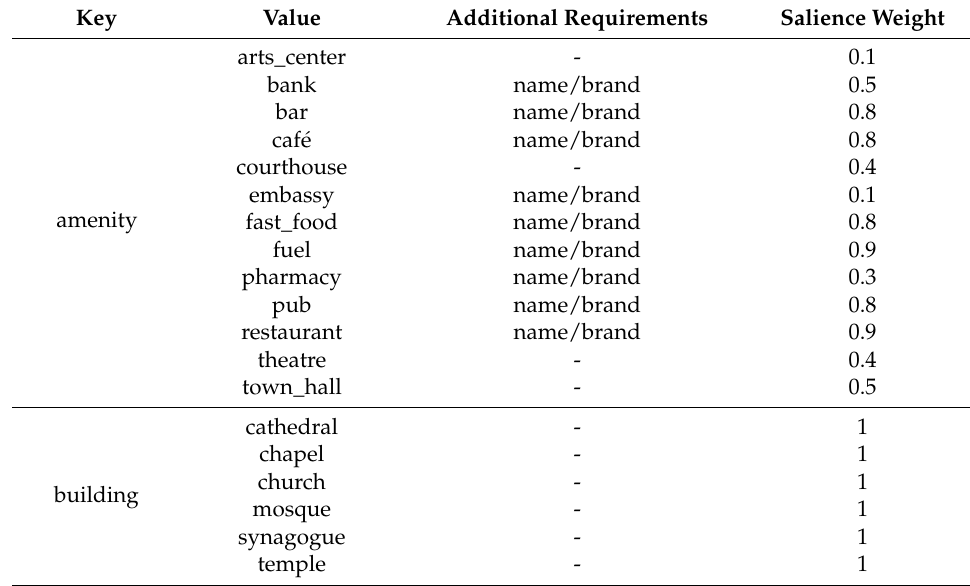
Table 1. Feature types used for landmark